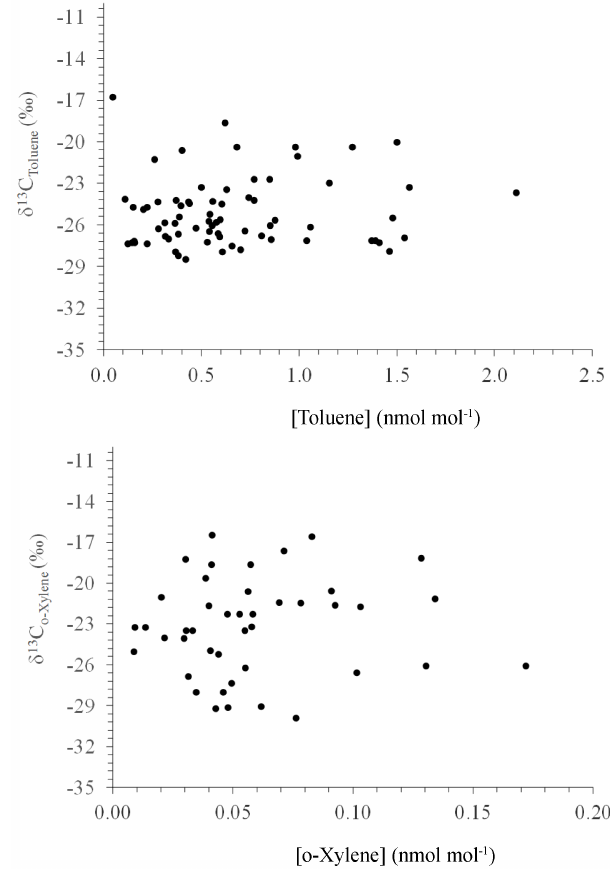
Figure 5. Example plots of VOC mixing ratios vs. carbon isotope